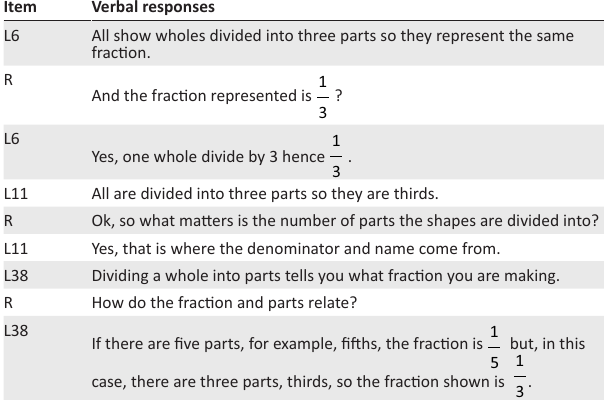
TABLE 5: Verbal responses of selected participants about Question 1.2. TABLE 4: Verbal responses of selected participants about Question 1.1.